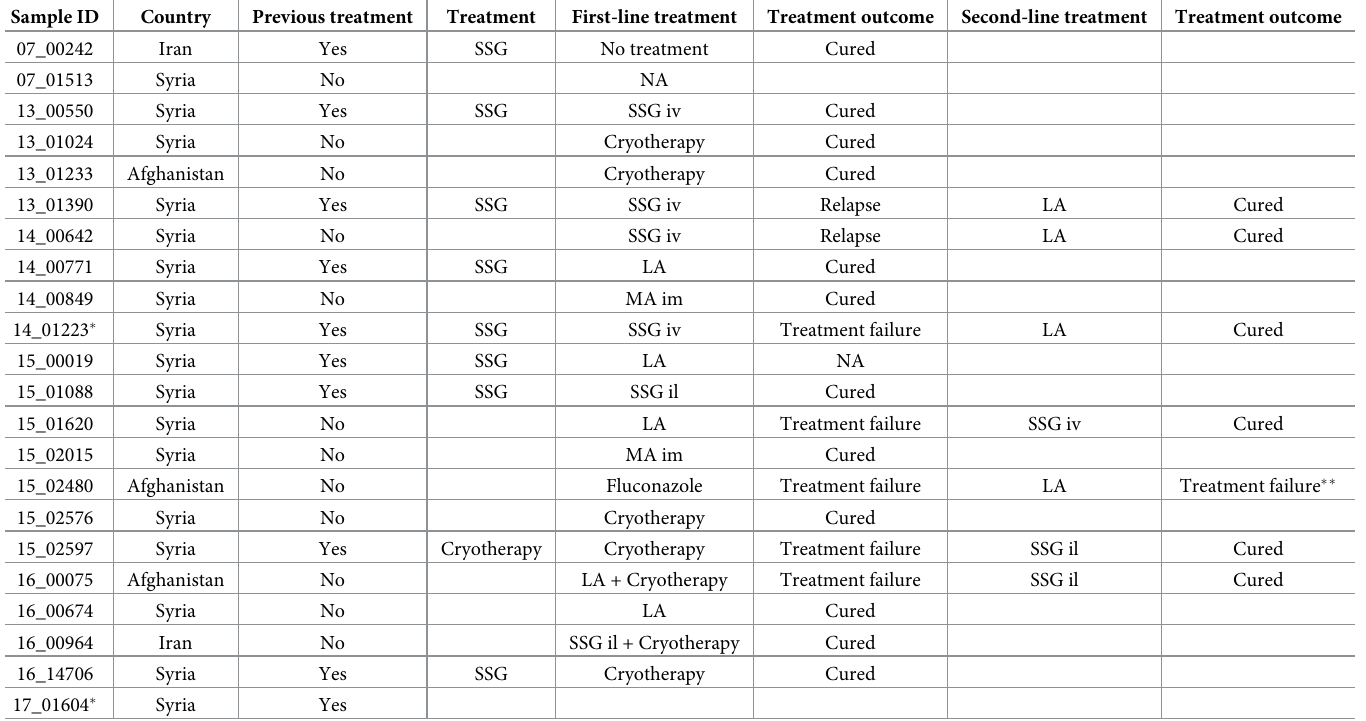
Table 1. 21 patients with 22 isolates of L . tropica ( � from the same patients) infected in the Middle East (three from Afghanistan, two from Iran, 17 from Syria). Ten had received treatment prior sampling (nine SSG, one cryotherapy) and twelve were cured on first-line treatment after sampling. Six were cured on second-line treat- ment (3 LA, 3 SSG il). One healed by itself and two were lost after sampling. One patient continued to relapse regarding treatment. �� healed by itself. SSG stands for sodium stibogluconate, LA for liposomal amphotericin, MA for meglumine antimoniate, il for intralesional, im for intramuscular, iv for intravenous, cured for absence of clinical relapse for 6months after treatment, relapse for recurrence of a lesion after the lesion had healed without any known new exposure to the parasite, treatment failure for absence of clinical signs of re-epithelialisation in the lesion during or within two months after